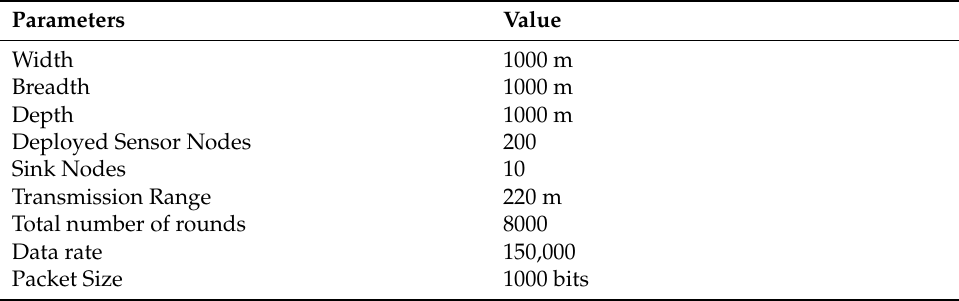
Table 1. Parameters Used in